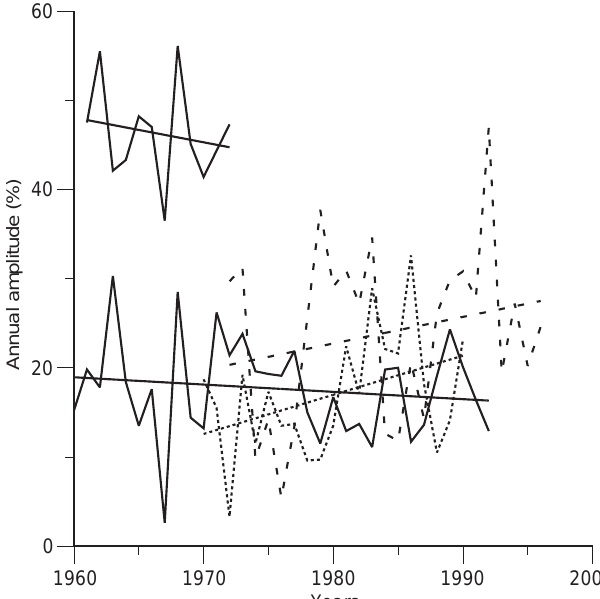
Fig. 4. Trends in the relative amplitudes of the annual wave ( AW / YC ) in absorption at 2775 kHz ( solid curve , top ), 164 kHz ( solid curve , bottom ), 1412 kHz ( dotted curve ) and 6090 kHz ( dashed curve )